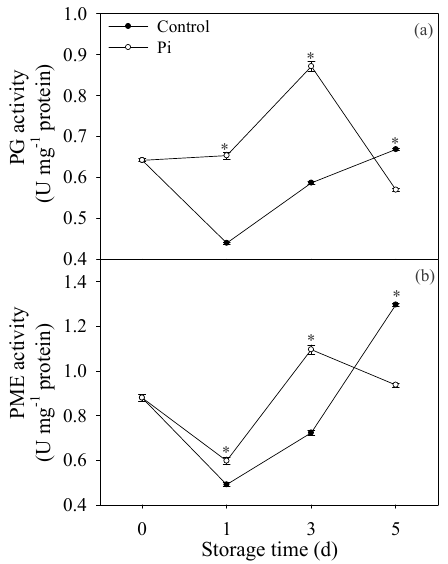
Figure 4. Effects of P. italicum infection on enzyme activity of polygalacturonase (PG) ( a ) and pectin methylesterase (PME) ( b ) of mandarin peel during storage at 25 ◦ C. Each data point represents a mean of three replicate assays ± standard error. Asterisks at the same storage time represented the significant differences ( P < 0.05).